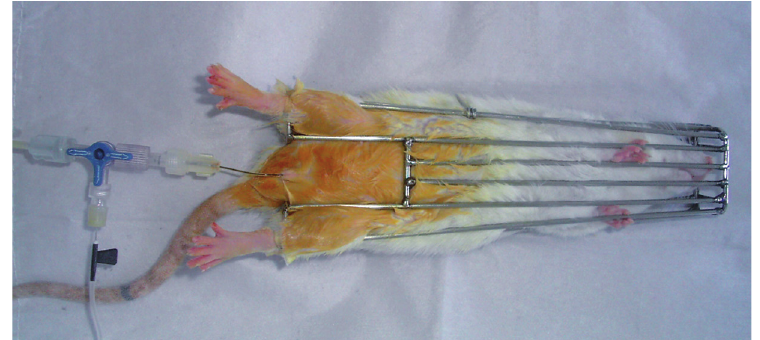
Figure 4 - The restraining device we designed which enabled cystometric